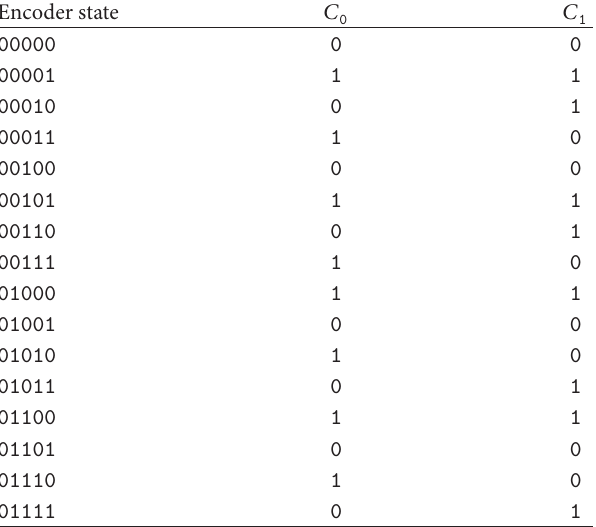
Table 2: The convolved output for input logic “ 0 ” and 2 𝐾−1 SR states with parity bits as output.